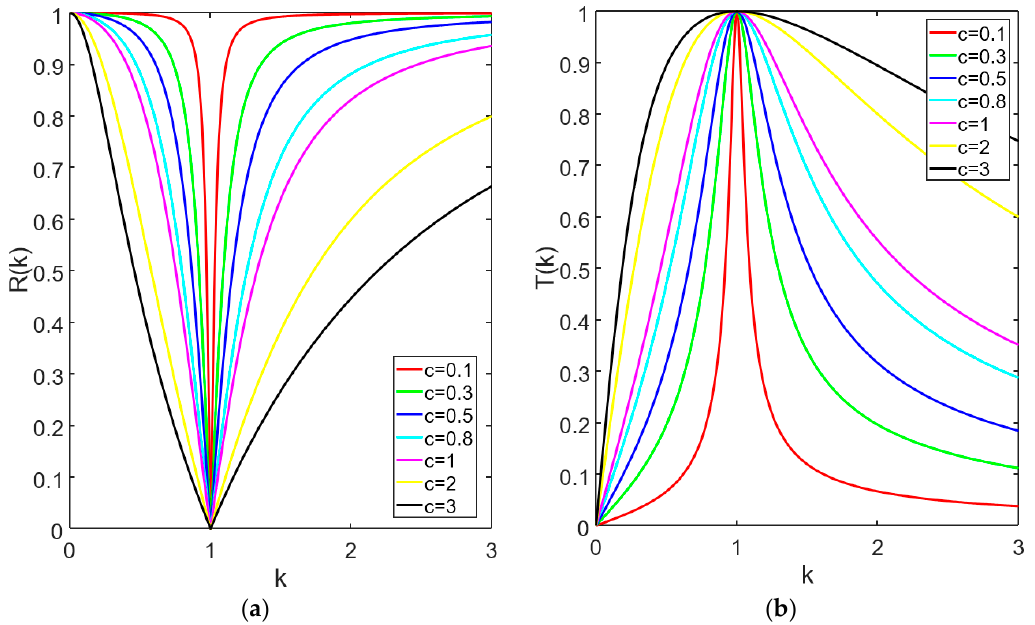
Figure 3. Construction component and circulation component.